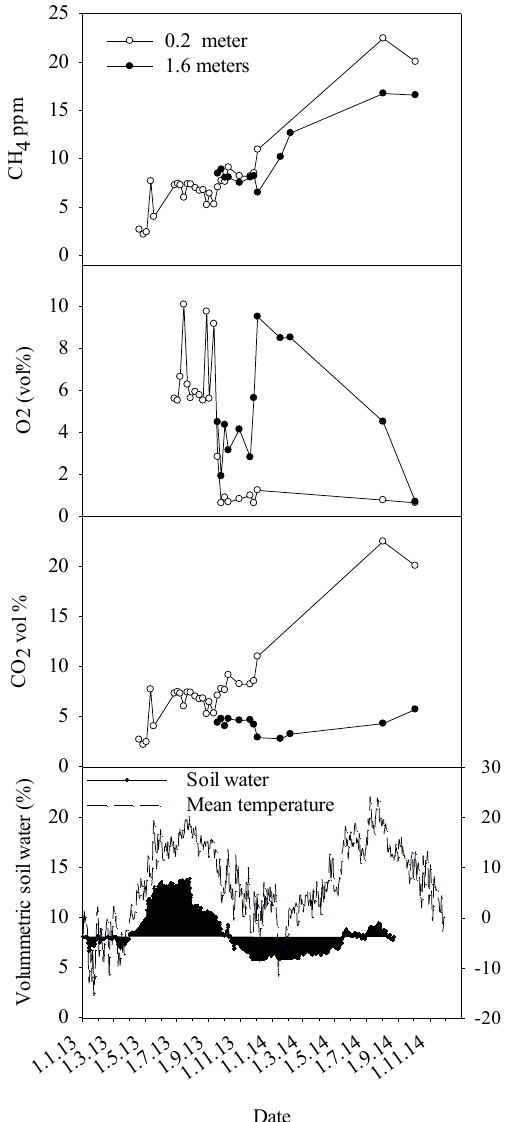
Figure 3. Evolution of in situ concentrations of CH 4, O 2 , and CO 2 at stump level and at breast height within the stem of Norway spruce tree #2 (age 110 y; breast height diameter 40.6 cm; height 27 m) at the Ås site. The tree was classified as healthy in 2013 but showed incipient infection by Armillaria sp. at stump height when it was felled in 2014. The lowermost panel shows mean daily air temperature and volumetric soil water content measured at a soil depth between 10 and 80 cm, obtained from Bioforsk Meterological Service at Ås. At stump level significant correlation ( p value < 0.01) was observed between CH 4 and O 2 (corr. coefficient −0.54), CO 2 and O 2 (−0.77) and CH 4 and CO 2 (0.7) stem concentrations. At breast height a significant correlation was observed between CO 2 and O 2